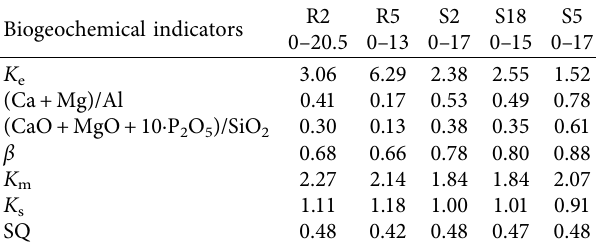
Table 5: Main biogeochemical indicators of the upper horizons of soils atop the division walls (R2, R5) and inside the fields of land plot S11-029 (S2, S5, S18). Biogeochemical